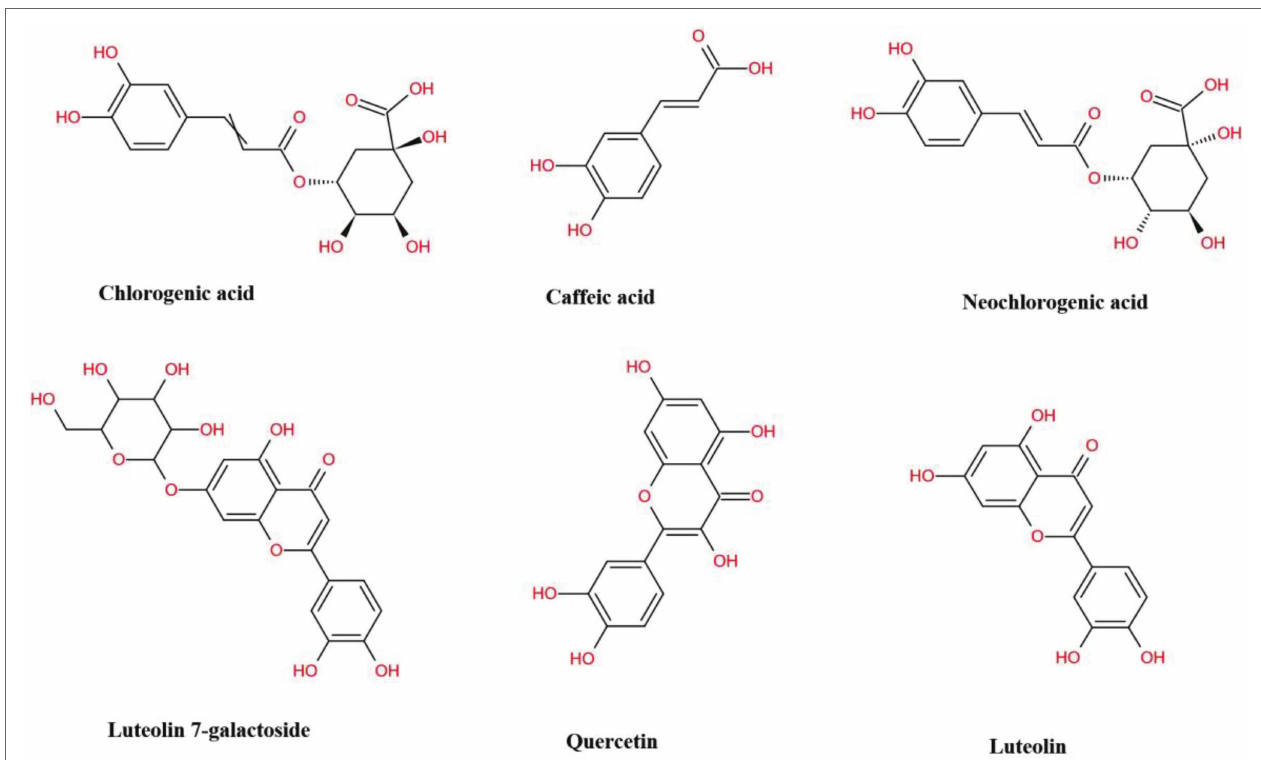
FIGURE 1 | The structural formula of major phenolic acids and flavonoids presenting in Lonicera japonica